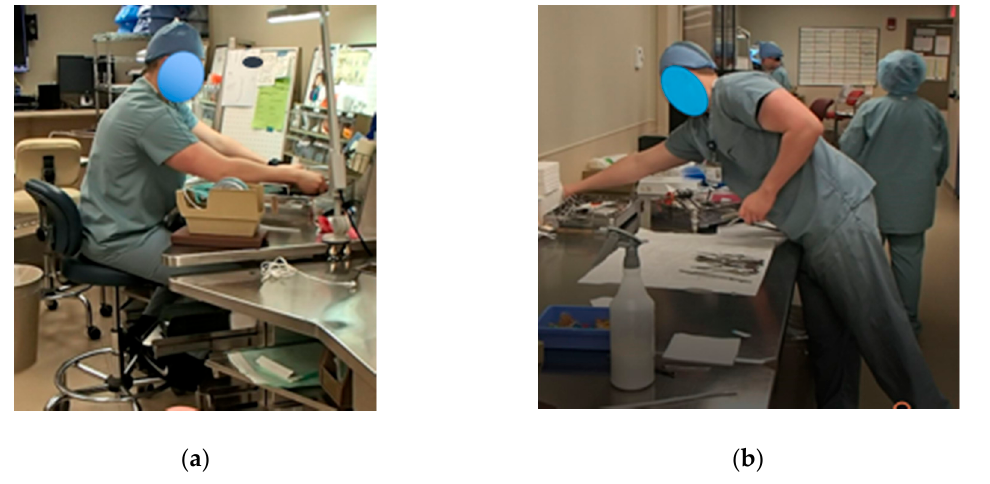
Figure 17. ( a ) Workstation Type 1, ( b ) and Workstation Type 2.